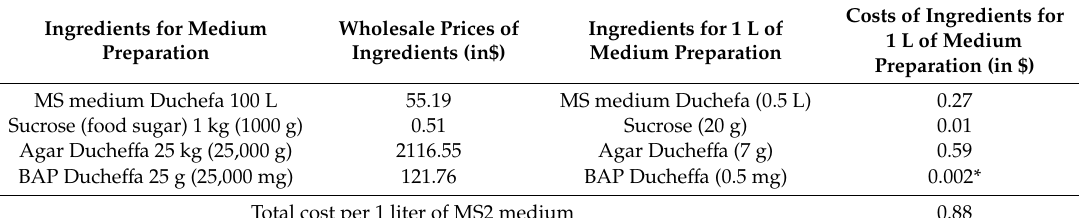
Table 2. Wholesale prices and costs of reagents used in P. tomentosa × P. fortunei plants production and reagents necessary for MS2 production. Ingredients for Medium Wholesale Prices of Ingredients for 1 L of Preparation Ingredients (in$) Medium